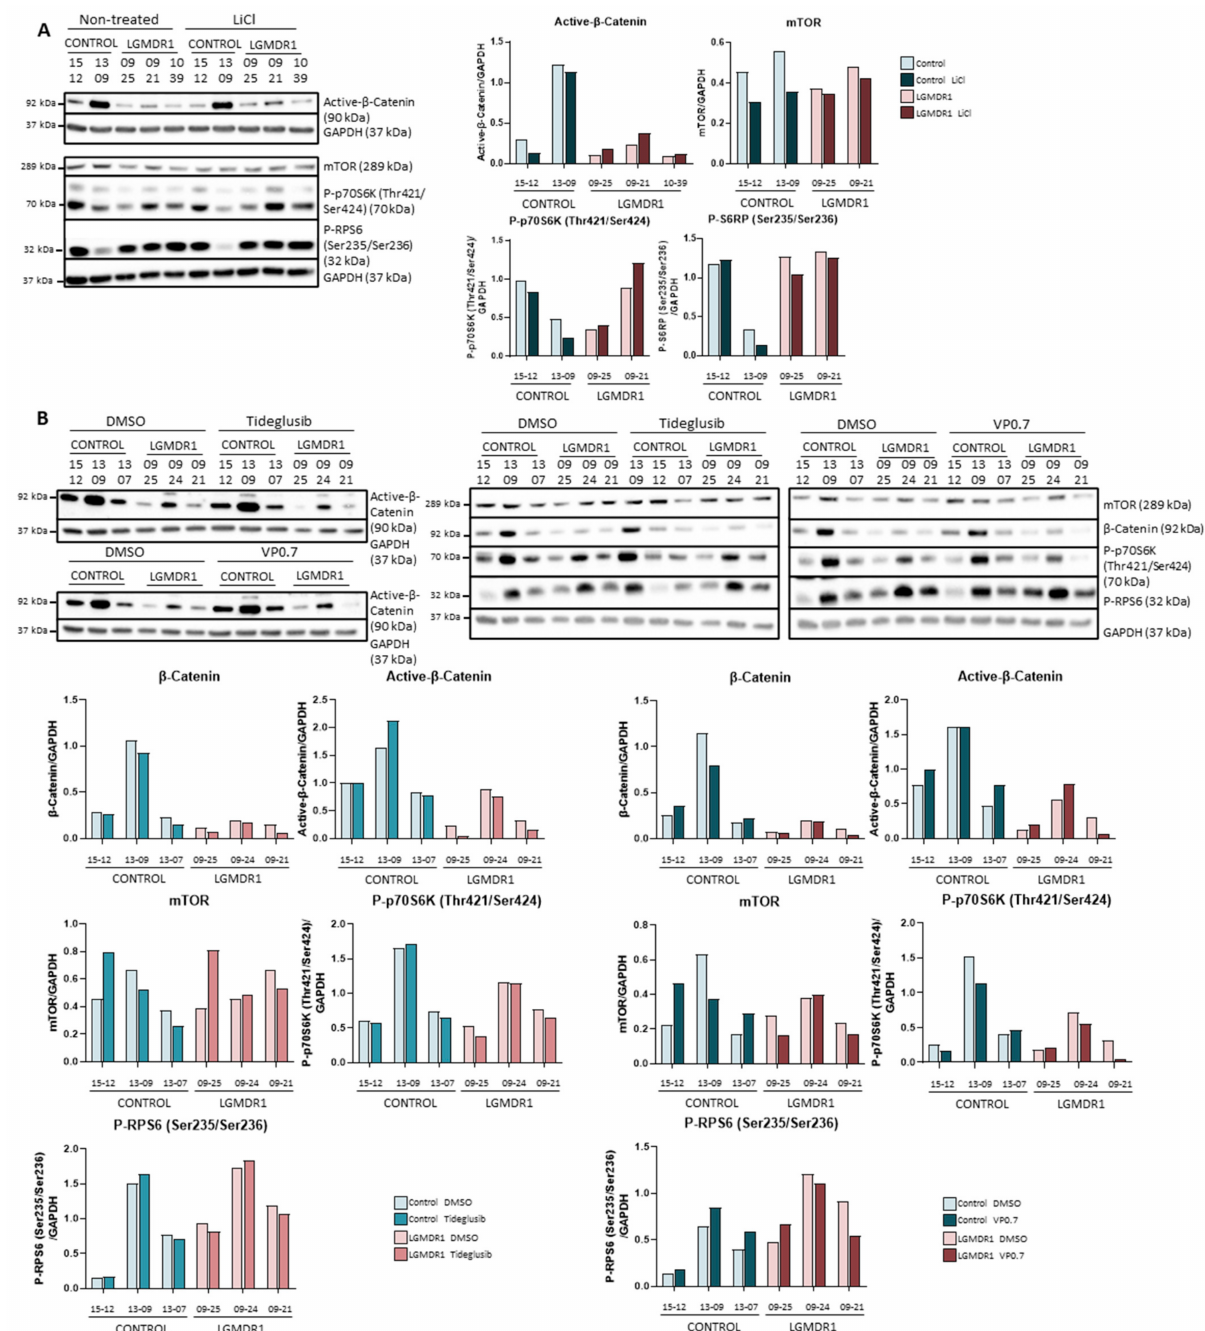
Figure 8. Analysis of CD56- cells treated with ( A ) LiCl (controls, n = 2 and LGMDR1 patients, n = 3) and ( B ) Tideglusib and VP0.7 (controls, n = 3 and LGMDR1 patients, n =